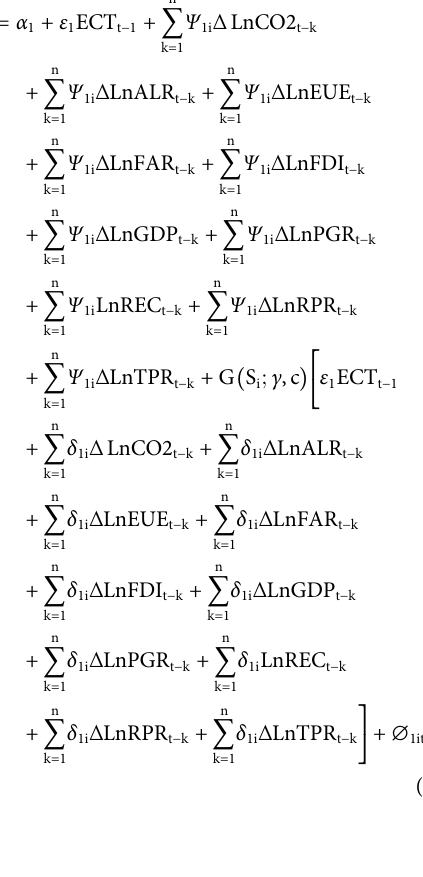
statistics and panel test statistics. Group mean statistics estimate the average outcomes of individual nation test statistics, while panel statistics assemblage the